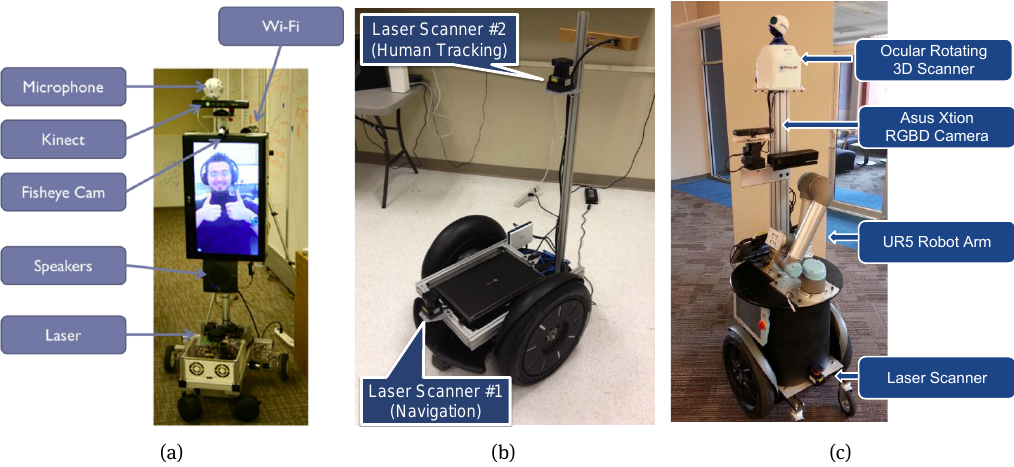
Figure 6: Robot platforms used in this paper. The robot shown in a) is a telepresence robot fitted with a Microsoft Kinect sensor. It was used for the person following experiments presented in Figure 5.1. The robot shown in b) has a Segway base with caster wheels, two laser scan- ners (one at torso height), and is used in human-aware path planning in Section 6.1.2. The robot shown in c) has a Segway base with caster wheels, has a UR5 robot arm, Ocular 3D rotating sensor and an Asus Xtion RGB-D sensor. This robot is used for the rest of the experiments including pointing gestures in Section 5.2 and context-aware person following in Section 6.2. All robot platforms have laser scanners for navigation.